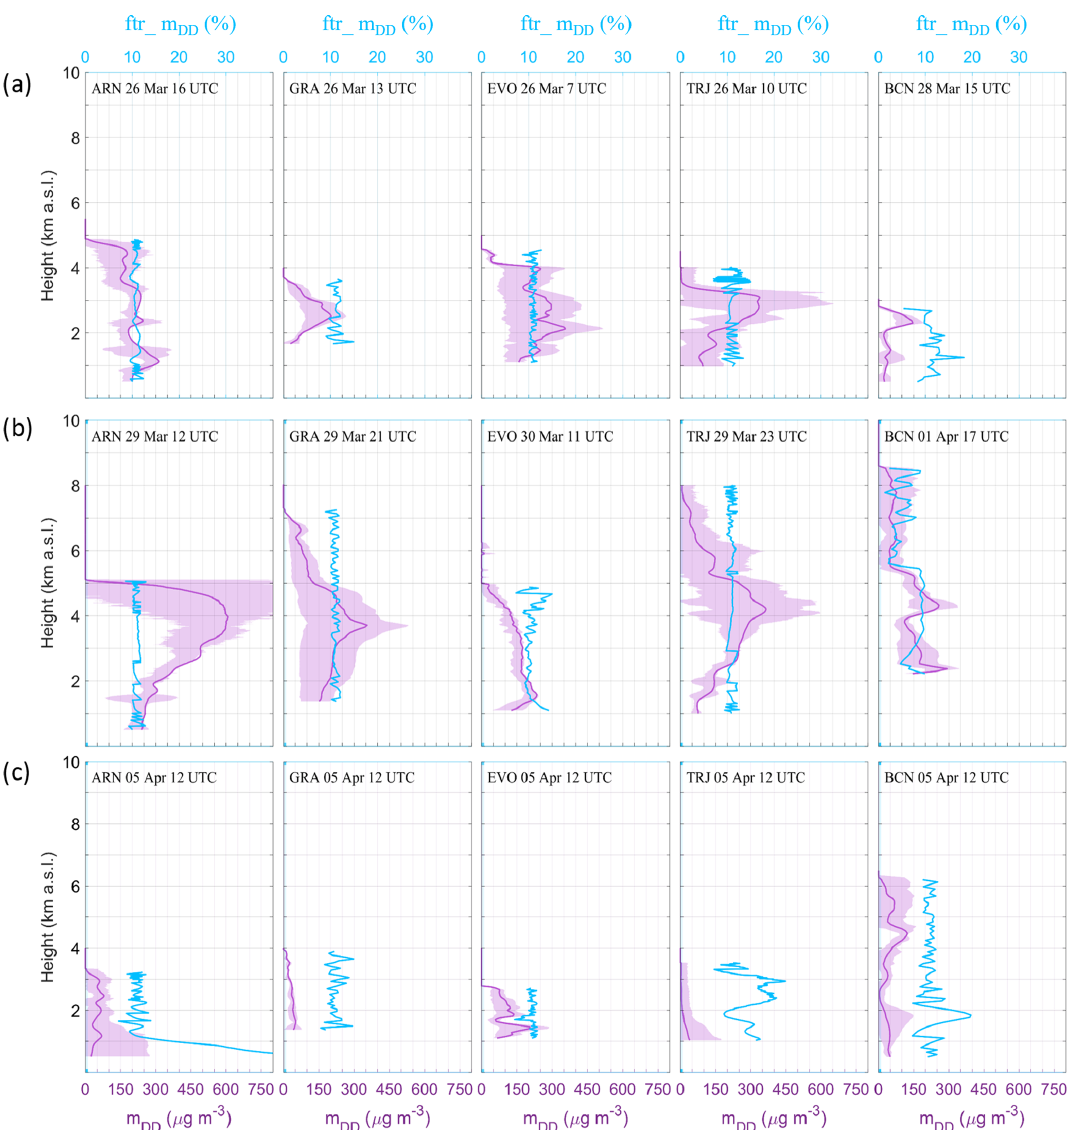
Figure 6. Dust mass features profiles for representative cases (date and time are shown in each panel): (a) beginning of the dusty event, (b) maximum incidence, and (c) end of the event, as observed at ARN, GRA, EVO, TRJ, and BCN. The total dust mass concentration, m DD (purple), together with the ftr_ m DD (%) (blue). Errors are shown by shaded